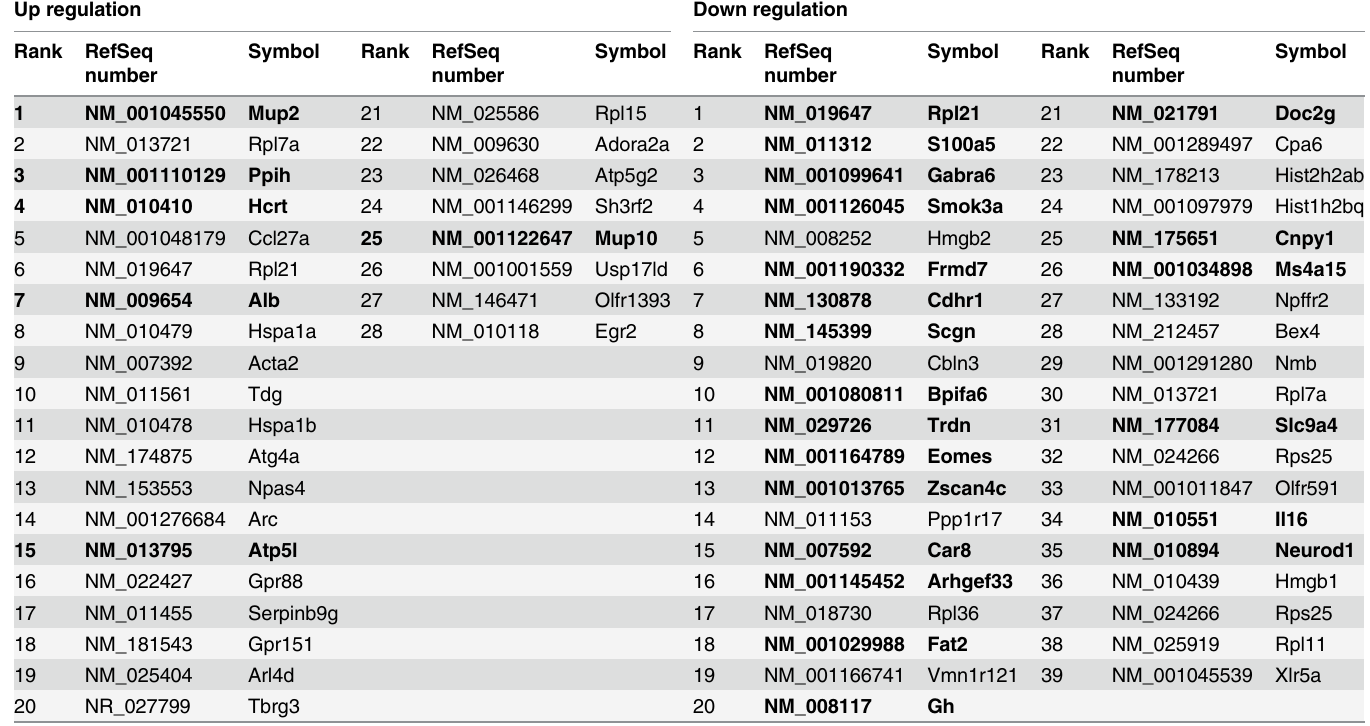
Bolded genes showed opposite expression pattern in P8 CE2 compared with R1